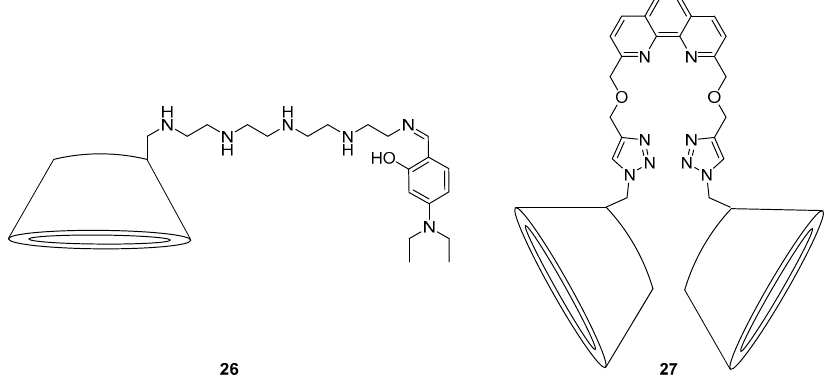
Figure 12. Both of these cyclodextrin-based probes respond selective to Zn 2+ . With 26 , Zn 2+ is thought to coordinate to the amines and hydroxyl group, triggering fluorescence enhancement and blue shift from 460 nm to 410 nm in water [101]. The bis -CD probe 27 responds to Zn 2+ with fluorescence enhancement and a red-shift in the emission wavelength from 368 to 377 nm